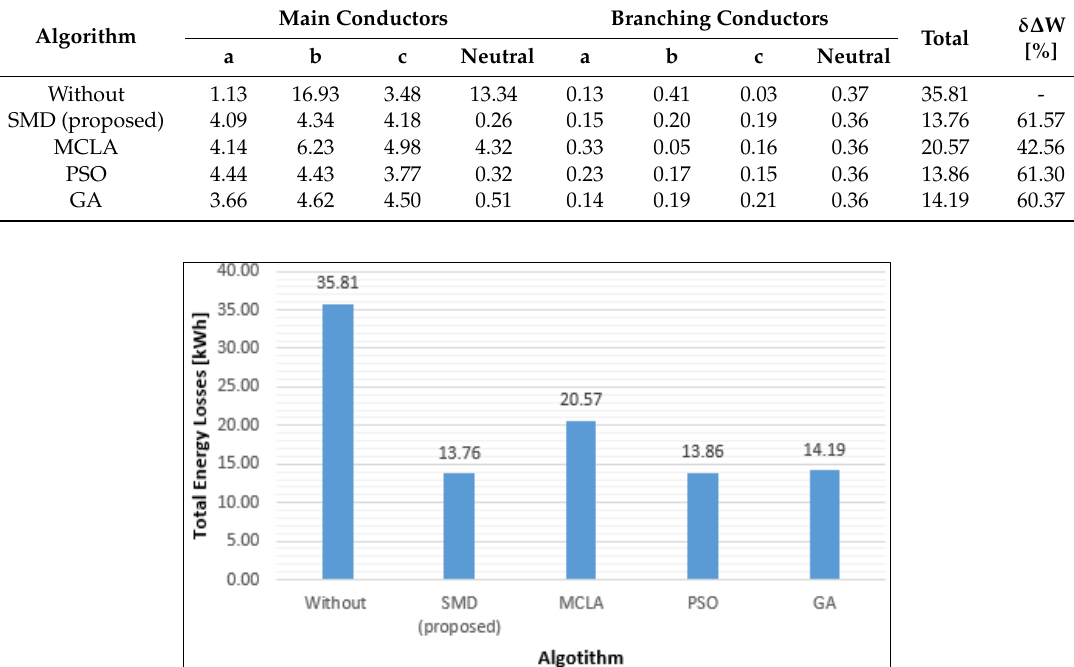
Figure 15. Comparison between the total energy losses, calculated with different algorithms.